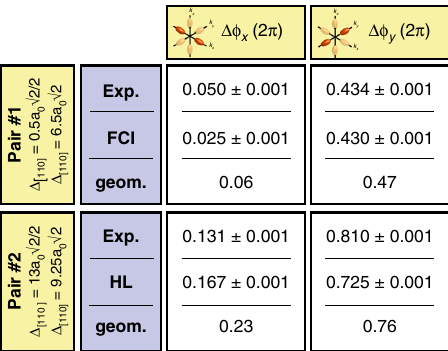
geom. Fig. 5 Table summarising the valley phase differences obtained for the two pairs. The x - and y -valley phase difference for each pair obtained from fi tting the 2D valley images can be compared to the geometrical phase differences obtained from the pinpointed lattice separation between the two donors along [110] and ½ 1 (cid:1) 10 (cid:2) and assuming a valley momentum at 0.81 k 0